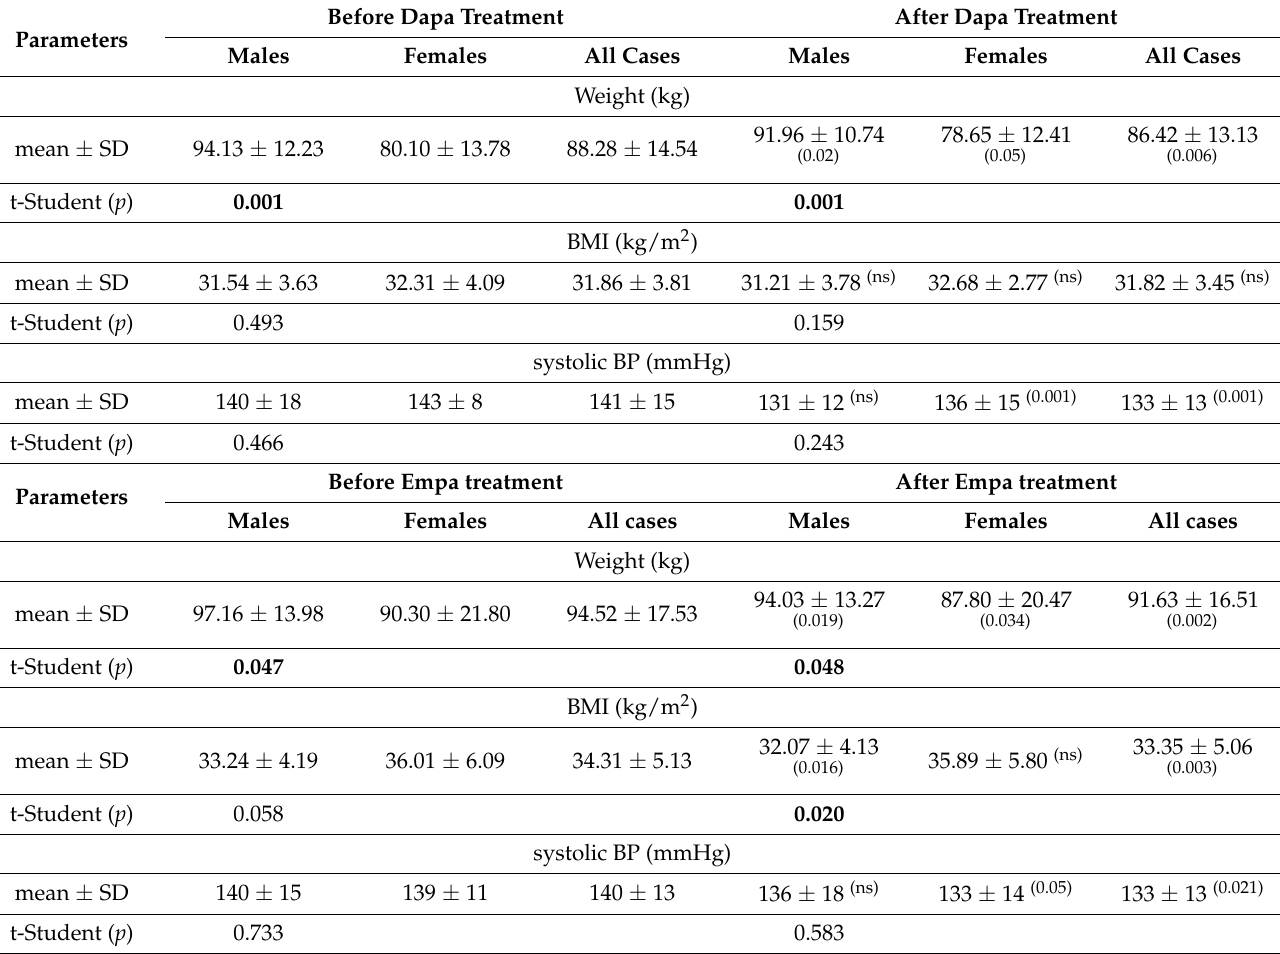
Table 2. The evolution of parameters after Dapa and Empa treatment,